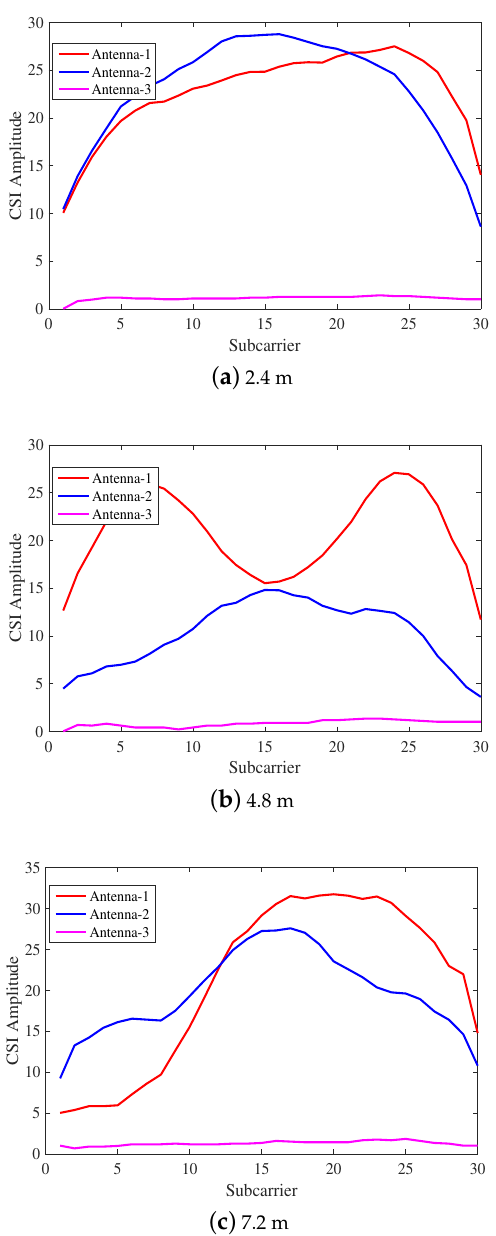
Figure 5. The CSI data noise reduction under different distances of indoor complex